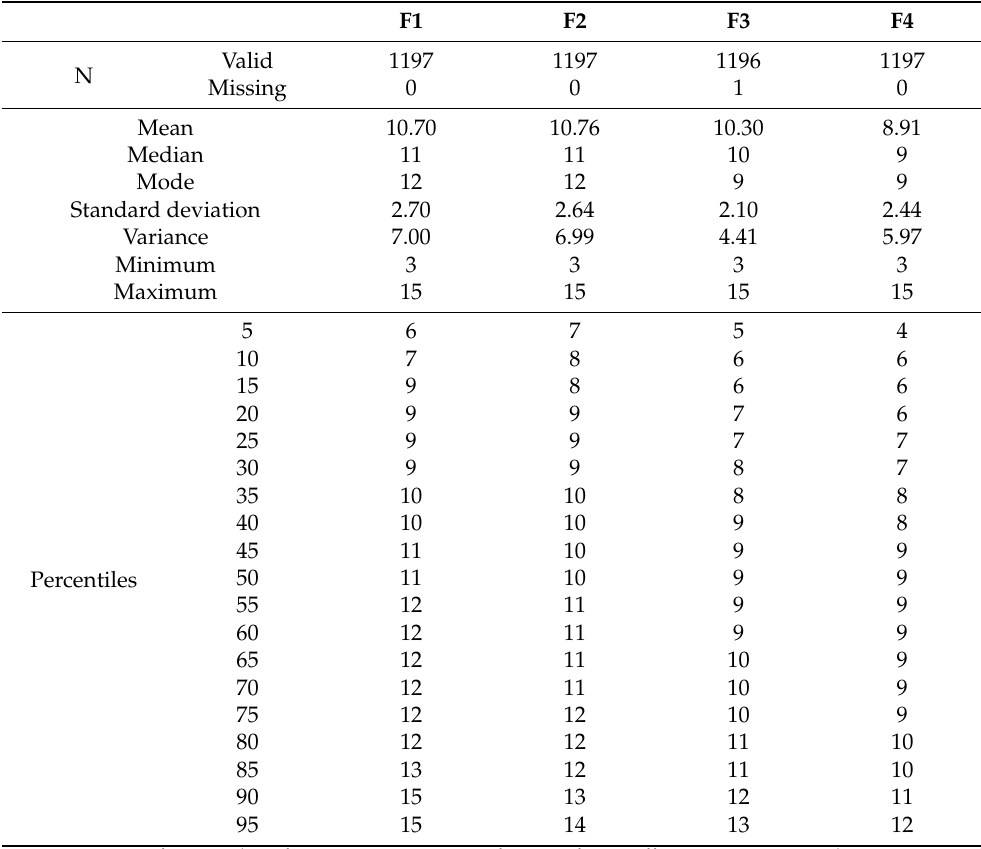
Table 4. Descriptive statistics and percentiles of the subscales of the Vaccination Attitudes Examina- tion